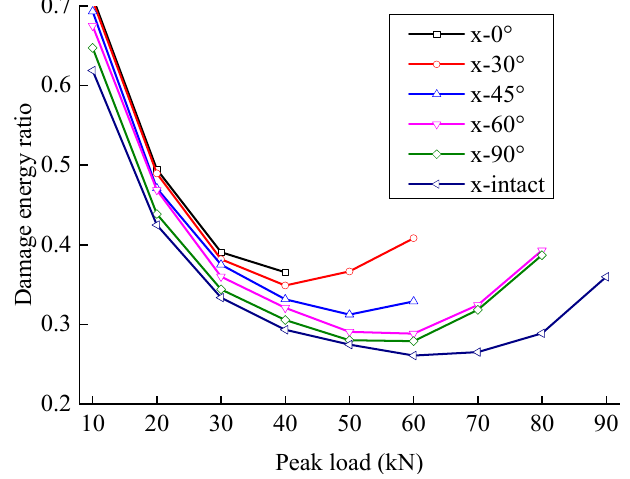
Figure 16. Damage energy ratio evolution curve of sandstone with different crack angles.